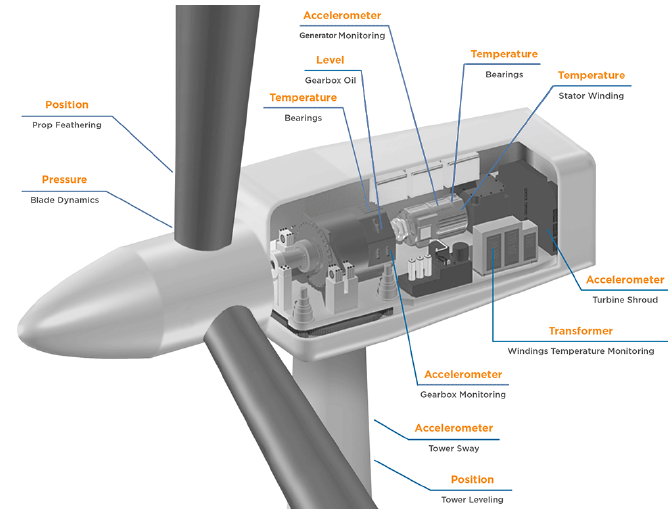
Figure 1. Example of Wind Turbine sensors types. Adapted from TE connectivity (available via license: CC BY 4.0)